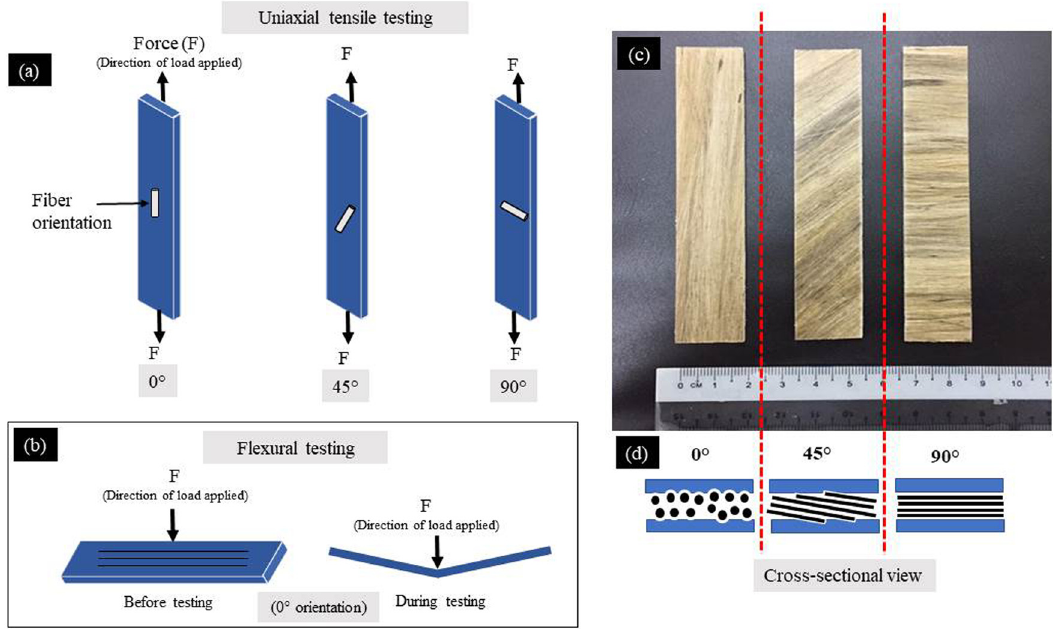
Figure 2: Schematic of samples in the ( a ) tensile and ( b ) fl exural tests. ( c ) Images of PLA – kenaf composites with di ff erent fi ber orientations. ( d ) Cross - sectional illustration of the composite